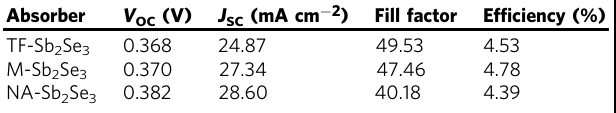
Table 1 Photovoltaic performance parameters for the Sb 2 Se 3 solar cells with different absorber structure (Fig.